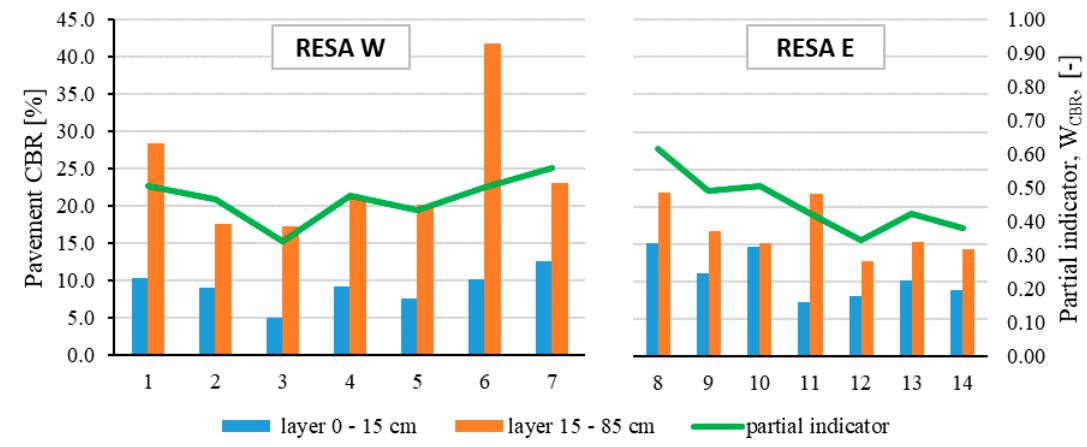
Figure 13. Results of the load bearing capacity of natural airfield pavements on the southern shoulder.